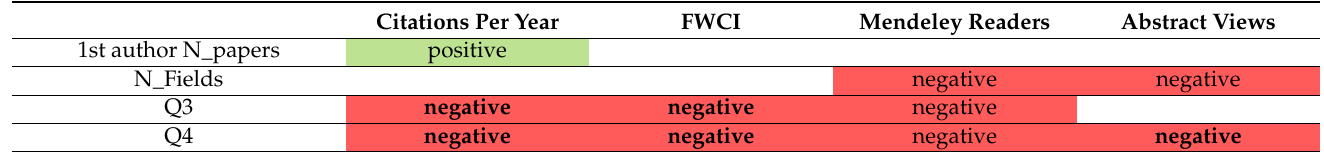
Table 4. Most important research impact